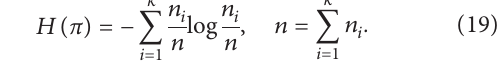
1 , EP 1 , and MP 1